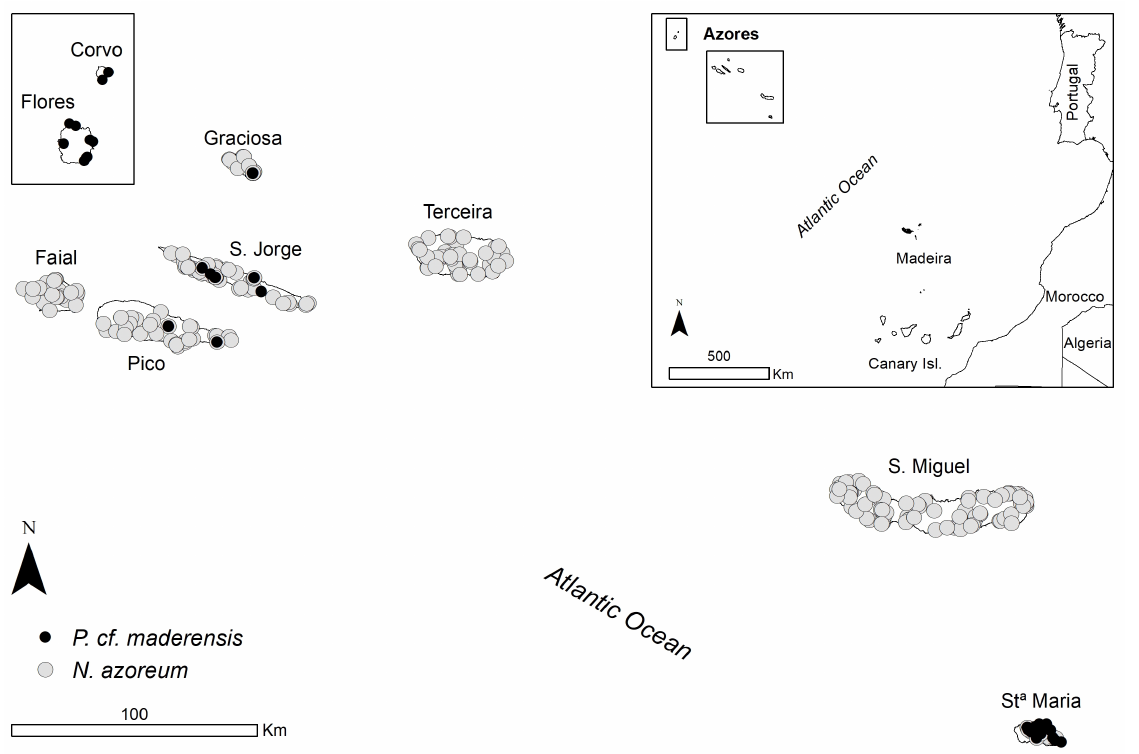
Figure 1. Map of the Azores islands with the known distribution of N. azoreum and P. cf. maderensis in the archipelago. The right-side upper panel shows the location of the Azores in context with western Europe and Africa and the Canary and Madeira Islands. Refer to this panel for the correct location of the islands of Flores and